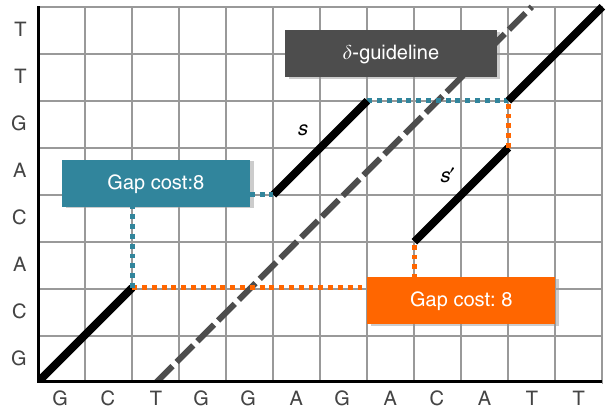
Fig. 5 Contradicting seeds. A scenario with two contradicting seeds s and s ′ . While extending the chain, chaining 11,27 – 29 is forced to choose one of both seeds. Abouelhoda et al. 21 use gap cost estimations, while Shibuya et al. 23 use accumulative seed lengths for making this decision. In contrast to our approach, however, both techniques cannot guarantee that the selected seed belongs to the best